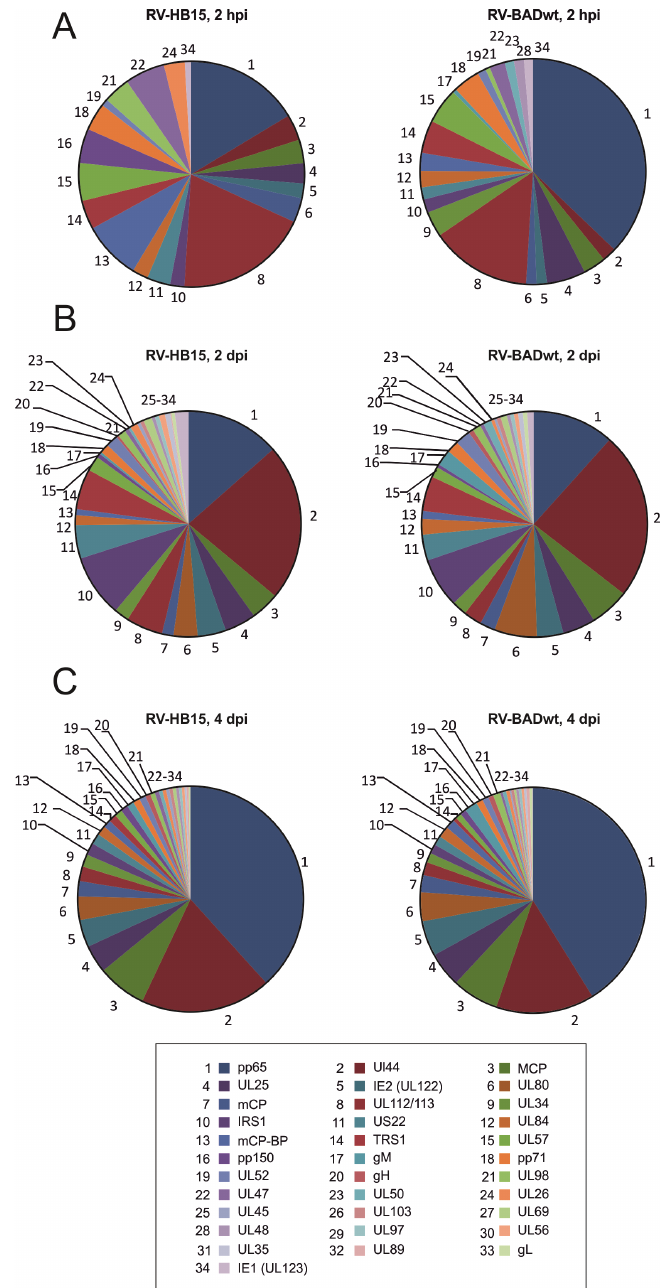
Figure 1. Proteomic analysis of viral proteins expressed in infected HFF. Fibroblasts were infected with RV-HB15 or RV-BADwt. At 2 hpi, 2 dpi, and 4 dpi, the cells were collected and analyzed, using nanoUPLC mass spectrometry. The relative abundance of individual proteins is shown in the pie charts. TOP3-Intensity was calculated as the average intensity of the three best ionizing peptides and is proportional to the molar amount of the respective protein in the sample. Proteins were sorted in decreasing abundance according to the values determined for four-day RV-HB15 infected fibroblasts and numbered accordingly, as indicated in the box. ( A ) samples obtained for analysis at 2 hpi; ( B ) samples obtained for analysis at 2 dpi; ( C ) samples obtained for analysis at 4